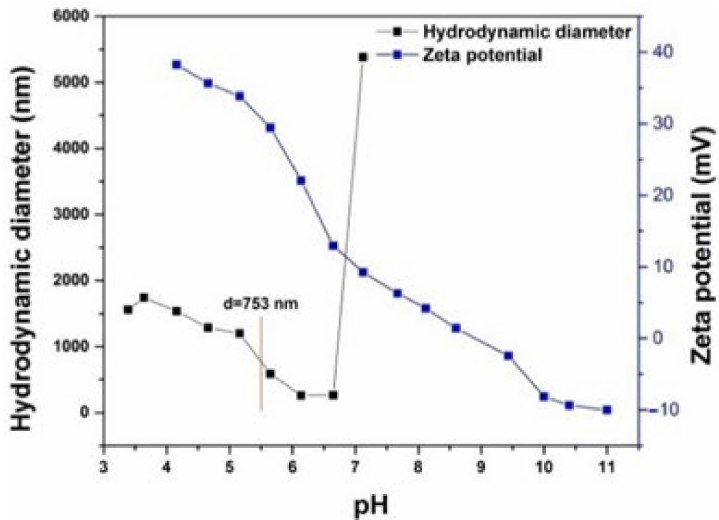
Figure 1. Zeta potential and hydrodynamic diameter of NCH+Zn; modified from